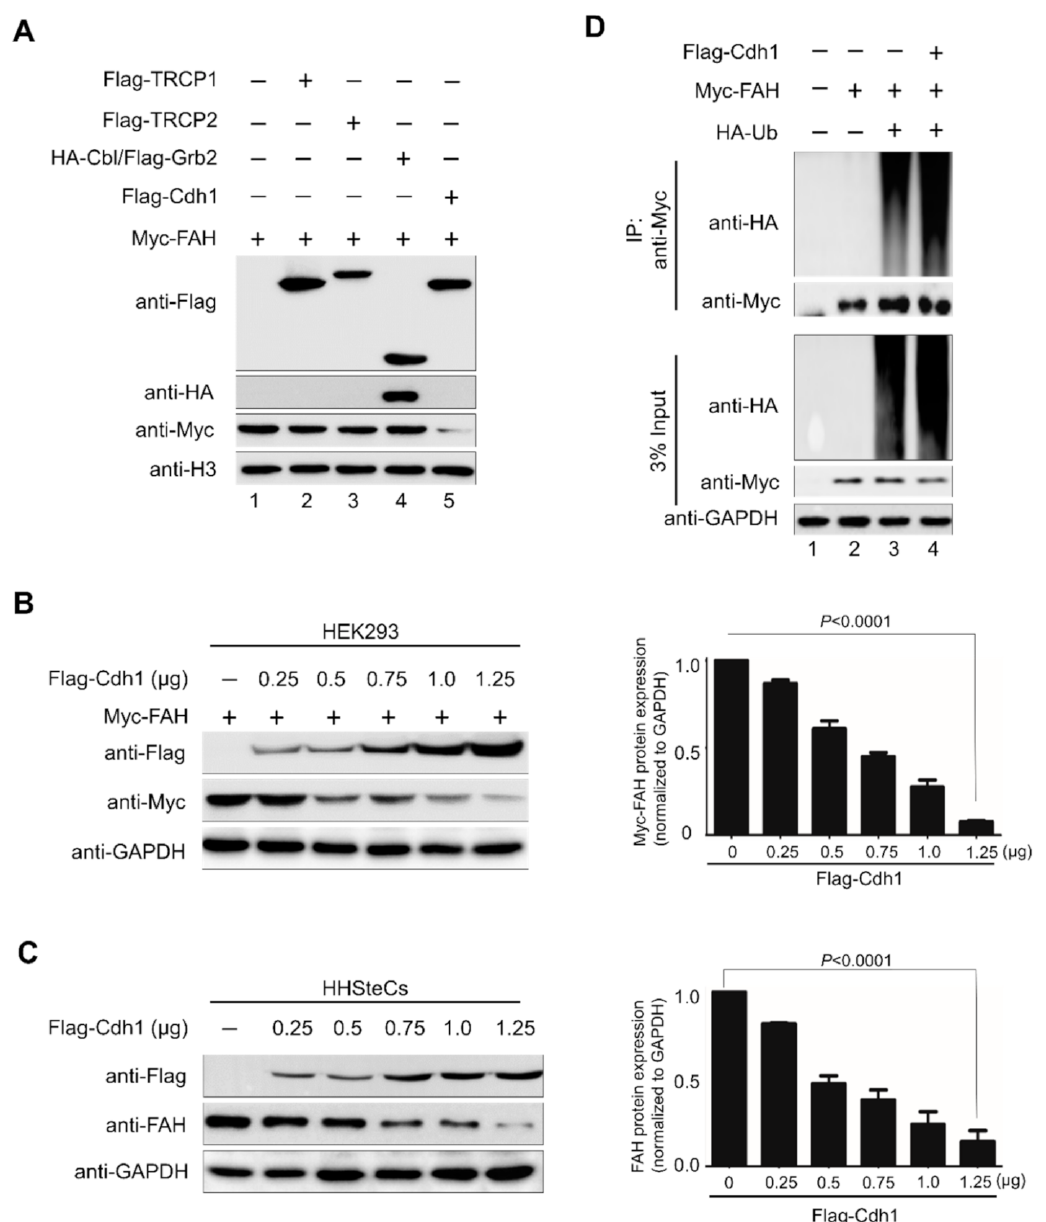
Figure 3. E3 ligase APC / C Cdh1 destabilizes FAH protein. ( A ) Screening E3 ligases for FAH. Several ligases were transfected transiently along with Myc-FAH in HEK293 cells and analyzed through Western blotting. ( B ) HEK293 cells were co-transfected with a constant amount of Myc-FAH along with Flag-Cdh1 at increasing concentrations (0, 0.25, 0.5, 0.75, 1.0 and 1.25 µ g). The Myc-FAH band intensity was estimated by ImageJ software and normalized with GAPDH for graphical representation. Data were presented as the mean and standard deviation of three independent experiments. One-way ANOVA followed by Tukey’s post hoc test was used and p -values are indicated. ( C ) HHSteCs were co-transfected with Flag-Cdh1 at increasing concentrations (0, 0.25, 0.5, 0.75, 1.0 and 1.25 µ g) and bands were analyzed by endogenous FAH antibody through Western blotting. The FAH band intensity was estimated by ImageJ software and normalized with GAPDH for graphical representation. Data were presented as the mean and standard deviation of three independent experiments. One-way ANOVA followed by Tukey’s post hoc test was used and p -values are indicated. ( D ) Myc-FAH was transfected with HA-ubiquitin along with Flag-Cdh1 in HEK293 cells to see the e ff ect of Cdh1 on the ubiquitination and proteolysis of FAH. Cell lysates were immunoprecipitated with Myc antibody followed by immunoblotting with HA or Myc antibody. GAPDH was used as a loading